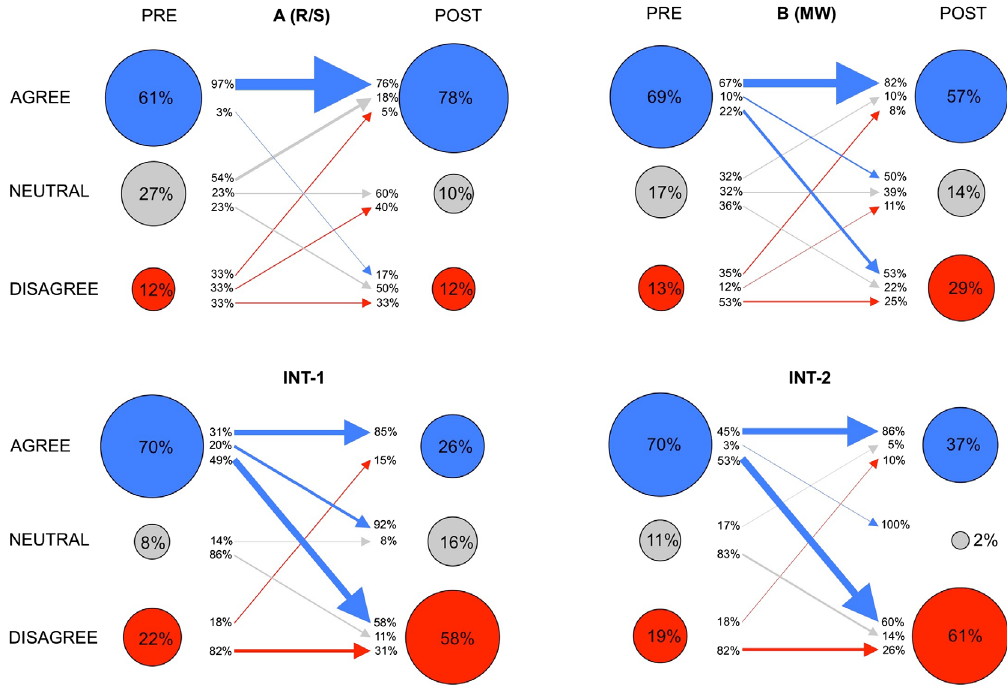
FIG. 9. Pre- and postinstruction responses from four modern physics courses (as described in the text) to the statement: When not being observed, an electron in an atom still exists at a definite (but unknown) position at each moment in time. N ¼ 49 ( A ), 126 ( B ), 77 (INT-1), and 57